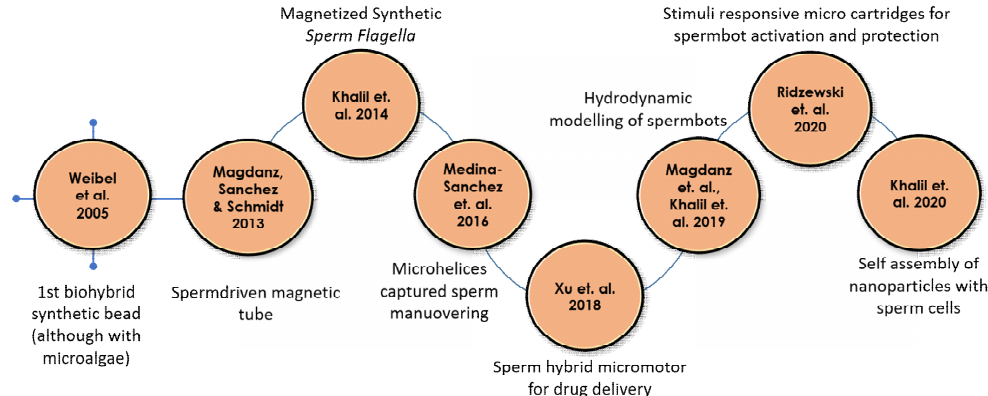
Figure 1. Timeline for biohybrid sperm development, starting with the first biohybrid synthetic bead. Details can be found in Table 1.